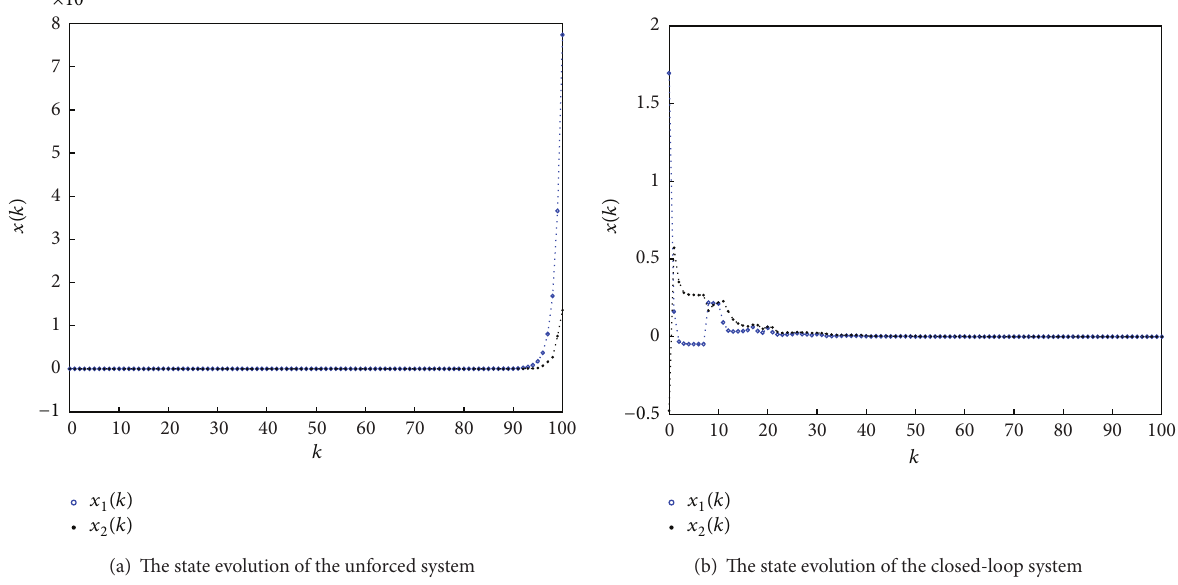
Figure 1: The comparison of state trajectories of the unforced and the controlled